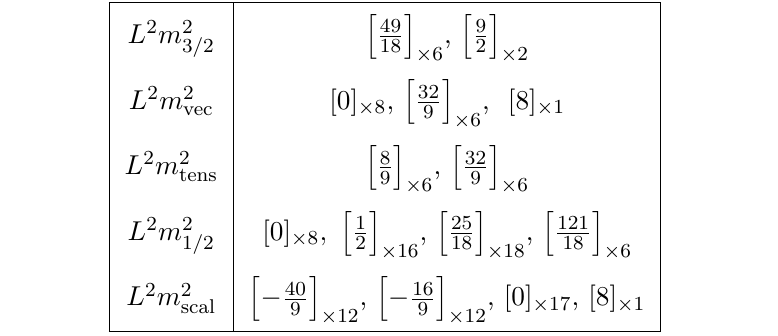
Table 10 . Masses for the AdS vacuum A3.